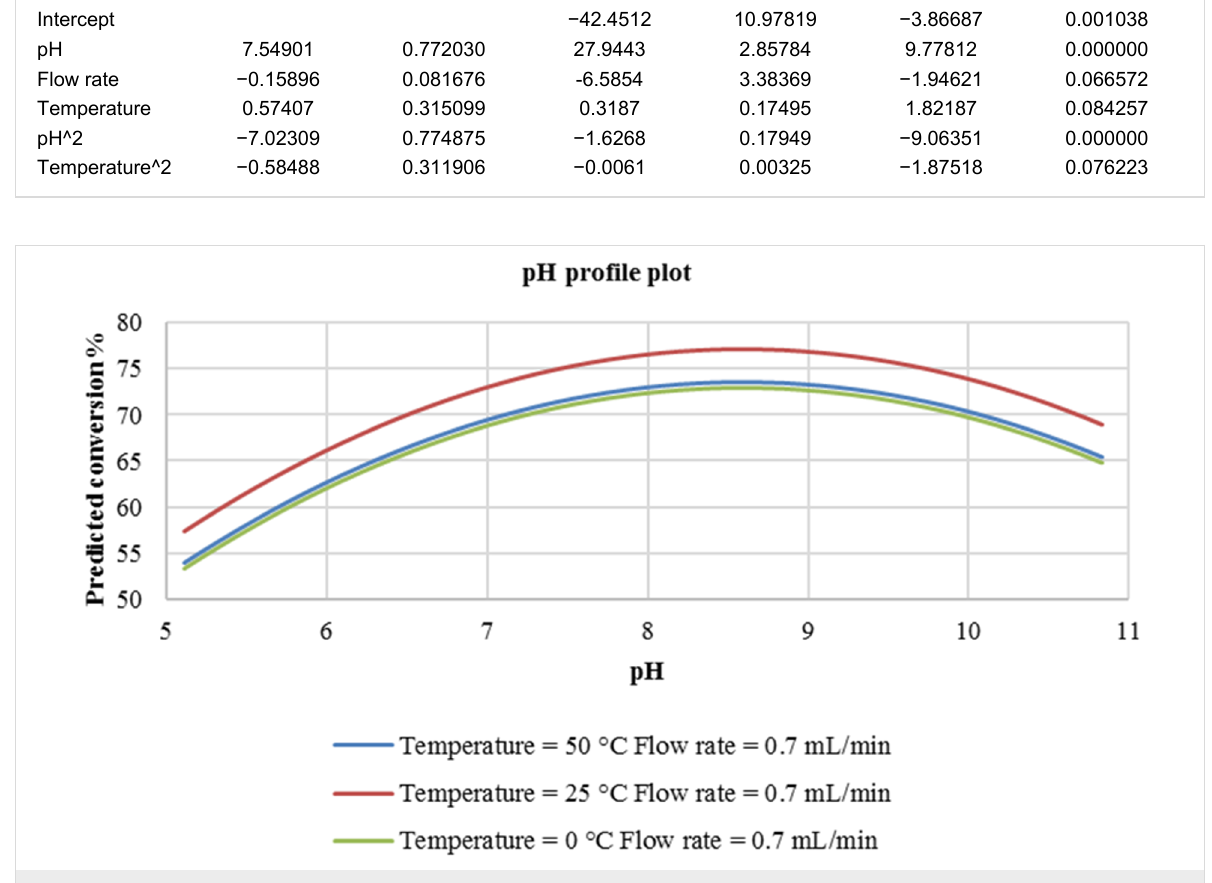
Figure 1: pH profile plot at constant flow rate of 0.03